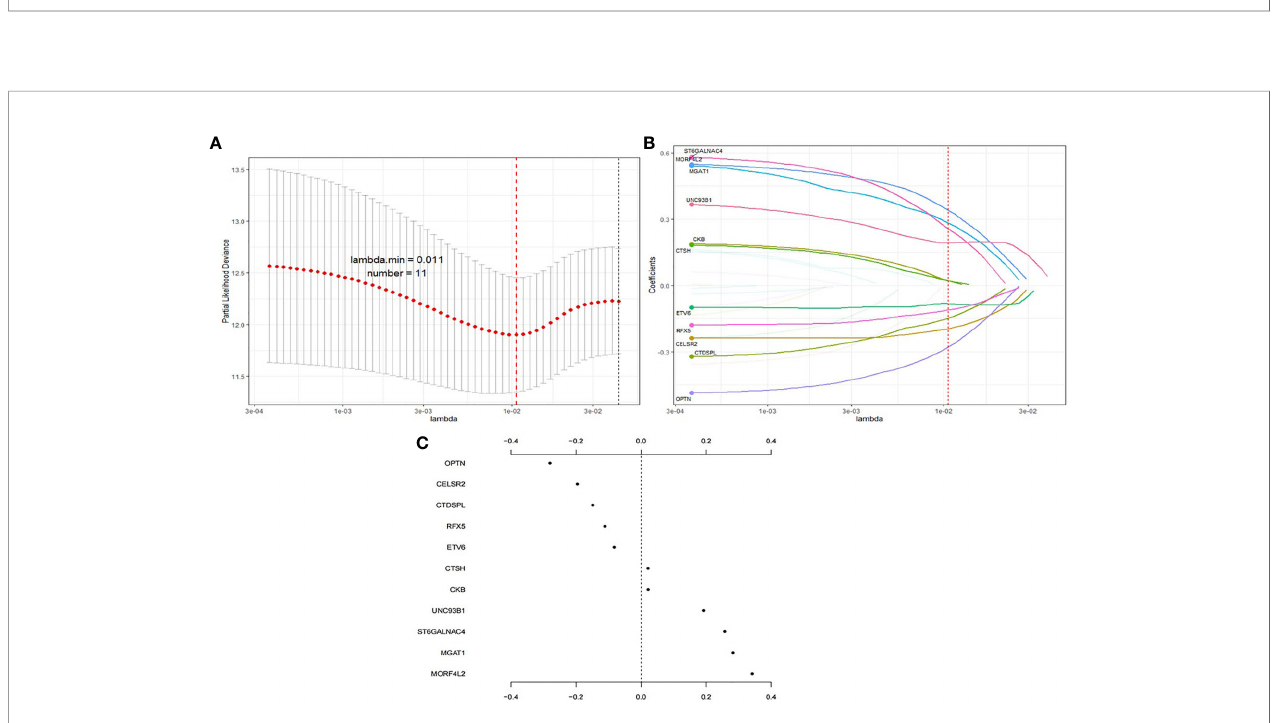
FIGURE 2 | Process of searching the most relevant mRNA module to RT response. (A) Soft threshold for the construction of the co-expression network. (B) R-squared of scale-free topology. (C) Cluster dendrogram of merged dynamic modules. (D) The correlation coef fi cients between modules and RT